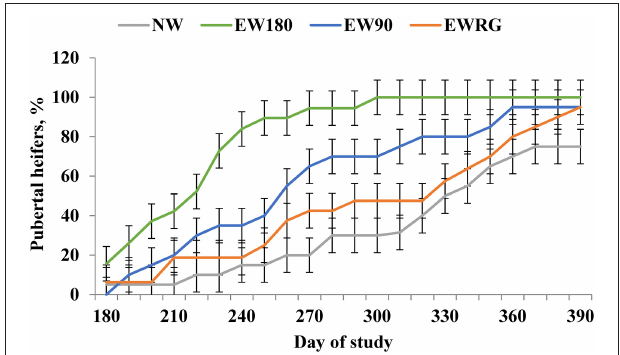
FIGURE 1 | Puberty achievement of replacement heifers developed on different calf management systems from the time of early-weaning (d 0) until the time of normal weaning (d 180). NW = heifers remained with cows until d 180; EW180 = heifers early-weaned and limit-fed a high- concentrate diet until d 180; EW90 = heifers early-weaned and metabolically imprinted, by limit- feeding a high-concentrate diet until d 90, then grazed on pastures until d 180; EWRG = heifers early-weaned, grazed on pastures until d 180. A treatment x day interaction ( P < 0.01) was detected for puberty attainment. Adapted from Moriel et al. (2014b).